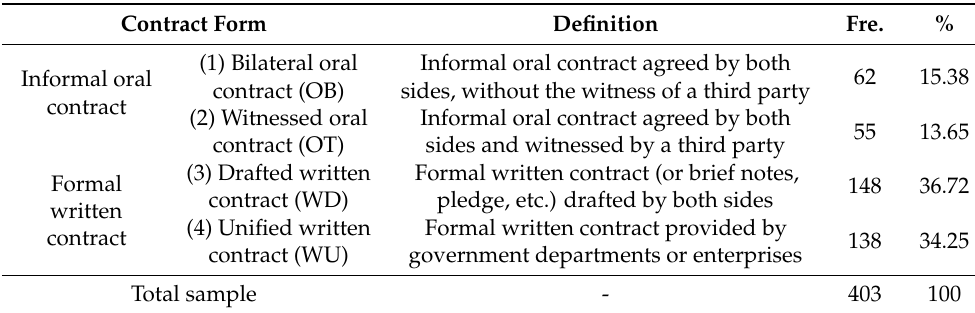
Table 1. Classification of contract forms and descriptive statistics. Contract Form Definition